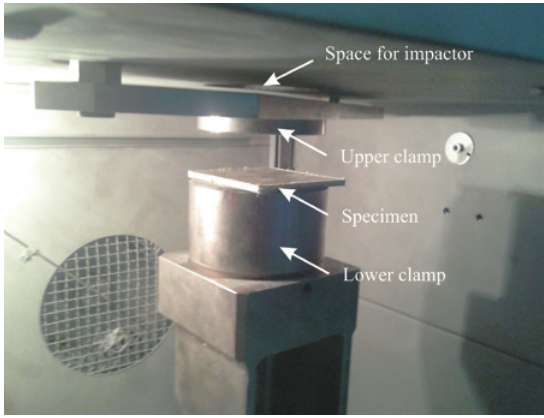
Figure 2: Specimen clamping